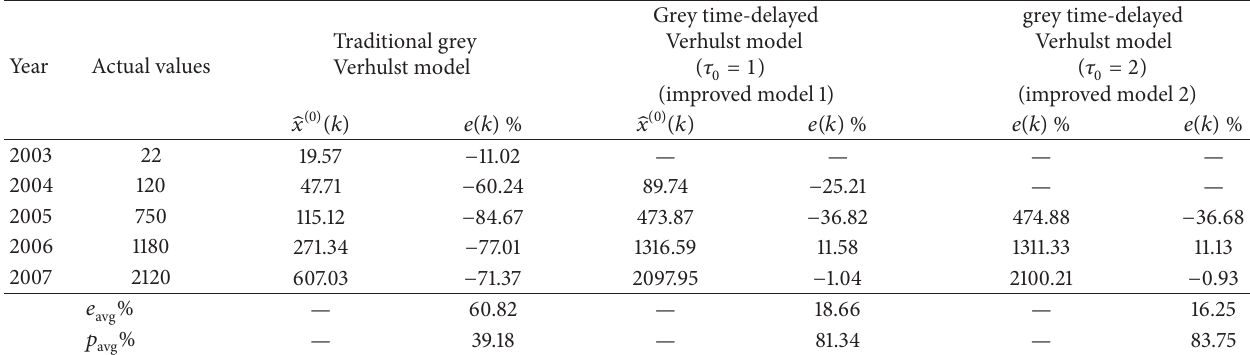
Table 2: Comparison of the modeling